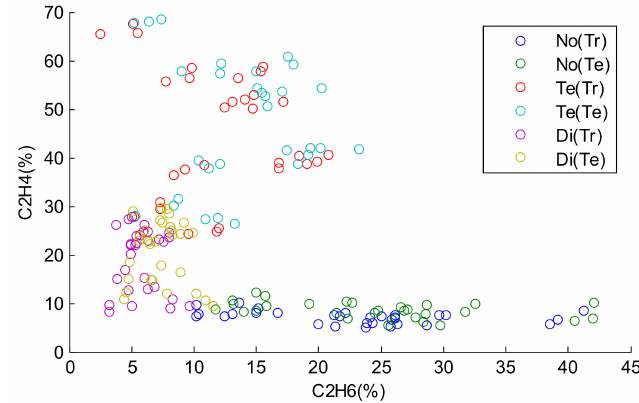
Figure 3. The distributions of the training samples and test